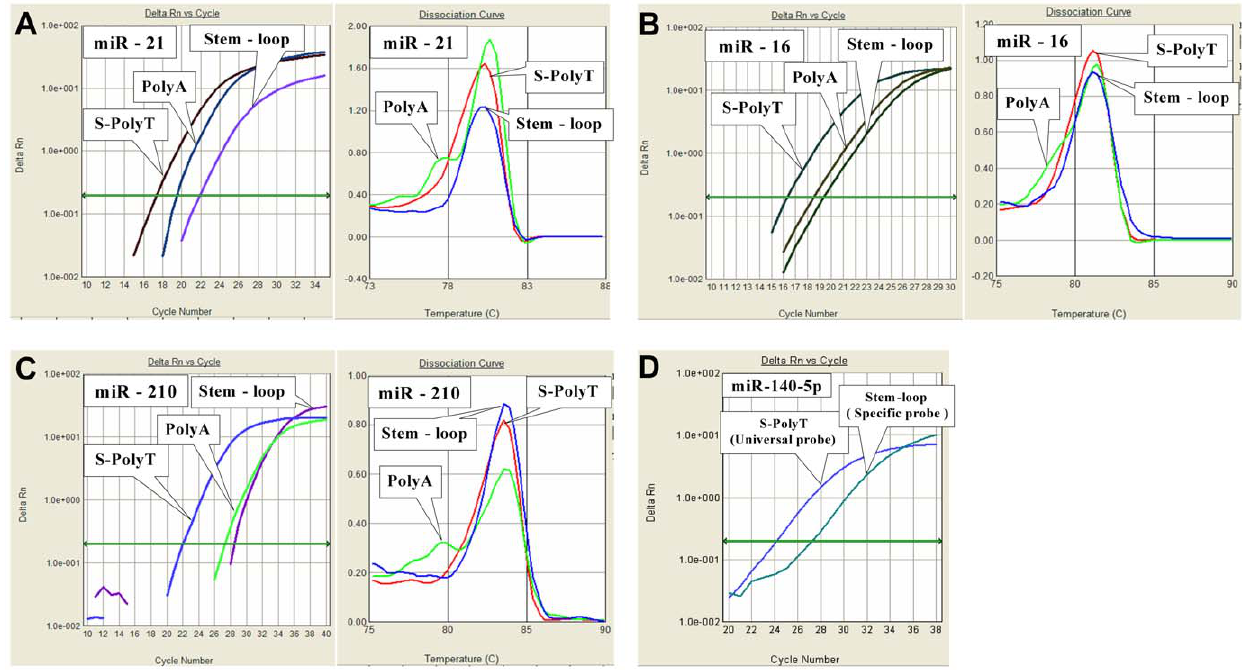
Figure 3. Comparison of the sensitivity of three different miRNA qPCR assays. Total RNAs were reverse transcribed into cDNA using S- Poly(T) RT primer, oligo(dT) RT primer and Stem-loop RT primer, respectively. Hsa-miR-21 (A), hsa-miR-16 (B) and has-miR-210 (C) were amplified and detected with SYBR Green I followed by melting curve analysis. Hsa-miR-140-5p was reverse transcribed into cDNA using the S-Poly(T) RT primer and the RT primer from TaqMan H microRNA assays kit (Applied Biosystems). The cDNAs were then amplified and detected with either a universal Taqman probe (S-Poly(T) method) or a specific Taqman probe (stem-loop method). The threshold was set at 0.2 on PRISM 7300 Real-time PCR system (Applied Biosystems). All PCR reactions were run in triplicate.